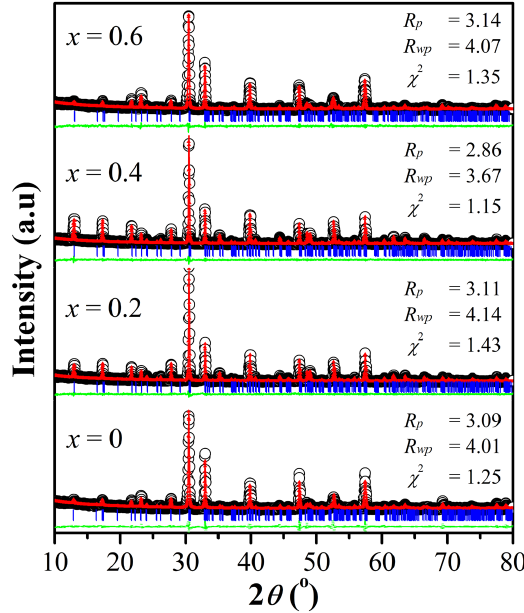
Bi LaTi Mn O with 1- x 3+ x 4- x x 15 - y (solid line obs cal 1